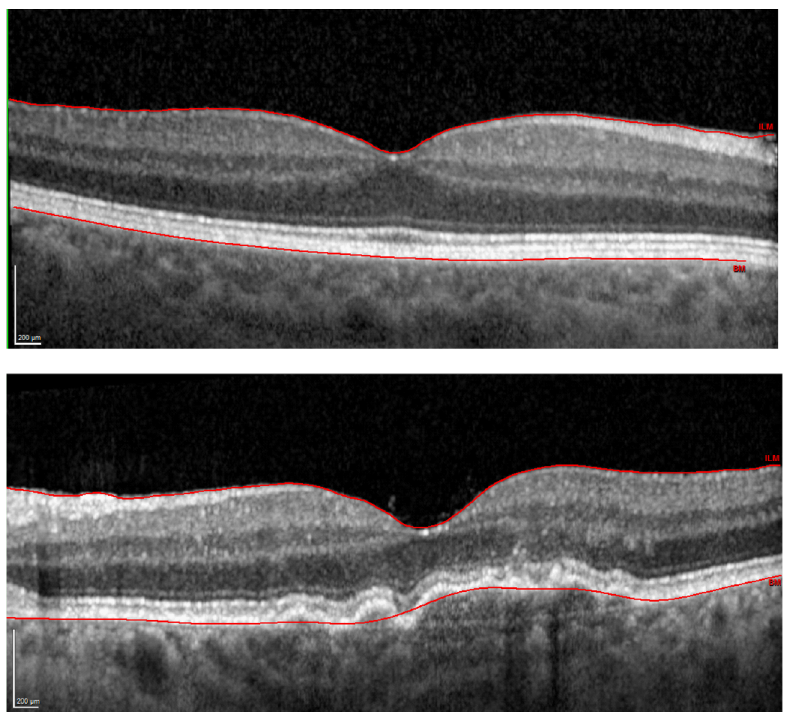
Figure 1. Optical coherence tomography images of a representative control (upper panel) and disease (lower panel) case. The solid red line indicates the automatic retinal layer segmentation, which defines the retinal thickness.